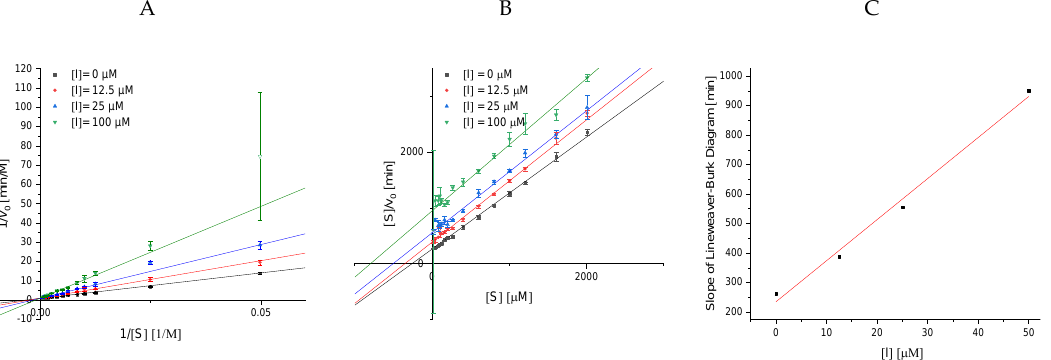
Figure A3. Linearized plots to evaluate inhibition type for Cyd-3-gal-xyl-glc(fer) (BC 4; A, B) and to demonstrate complete inhibition ( C ) (R2 = 0.99). Lineweaver − Burk plot ( A ); Hanes plot ( B ). Abbr.: [S], substrate concentration; [I], inhibitor concentration; v 0 , measured conversion rate at used substrate and inhibitor concentration.